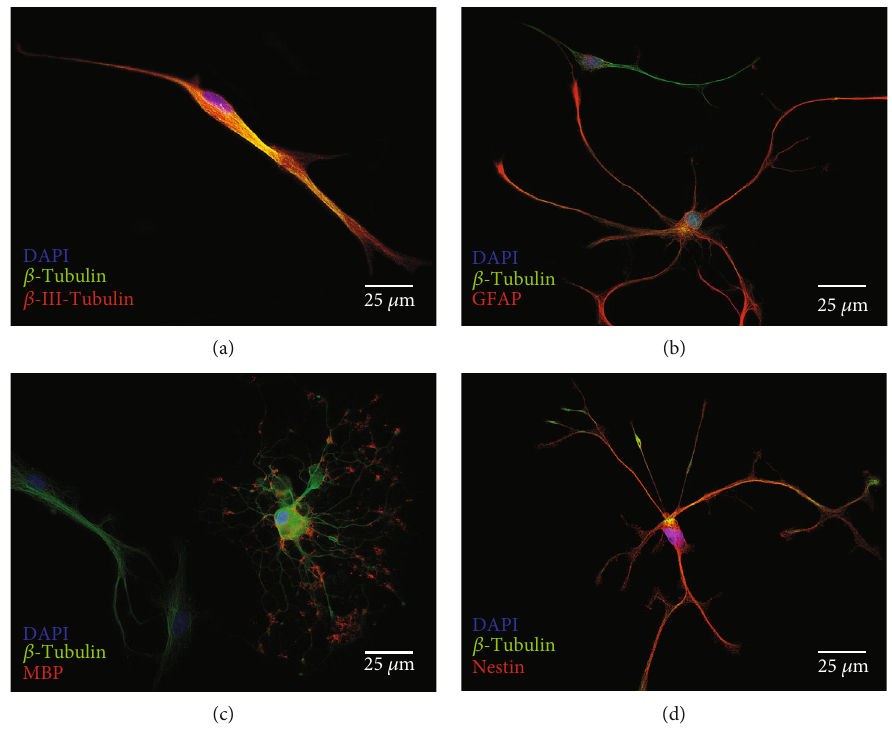
Figure 8: Di ff erentiated cells from IC. NSCs after 6 days on glass coverslips in di ff erentiation medium (DIF). (a) β -III-Tubulin (red) marked neuronal di ff erentiated cells. The β -III-tubulin-positive cells had neuron-typical spindled, slender somata with bipolar axon con fi guration. (b) Astrocytes were identi fi ed by the staining of glial fi brillary acidic protein (GFAP, red). These cells showed stellate-con fi gured branches, which is typical for astrocytes. (c) Oligodendrocytes showed positive labelling of myelin basic protein (MBP, red). Typically for oligodendrocytes, they had a peripheral-starting myelination, which is characterized by MBP staining. The proximal portions are β -tubulin-positive (green). The extensive, diversi fi ed growth of the branches is a morphological sign for oligodendrocytes. (d) Cells that were still in the undi ff erentiated progenitor cell stage were stained by Nestin (red). These cells had a very similar morphology to that of the GFAP- positive, astrocyte-di ff erentiated cells. They have multipolar branches, which are labelled positively for Nestin. The cytoskeleton of all viable cells was stained by β -tubulin (green). Cell nuclei were stained with DAPI